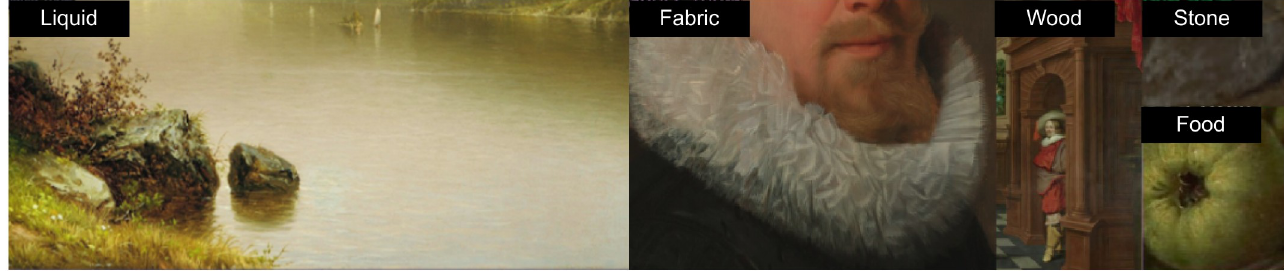
Fig 10. Examples of detected materials in unlabeled paintings. Automatically detecting materials can be useful for content retrieval for digital art history and for filtering online galleries by viewer interests.